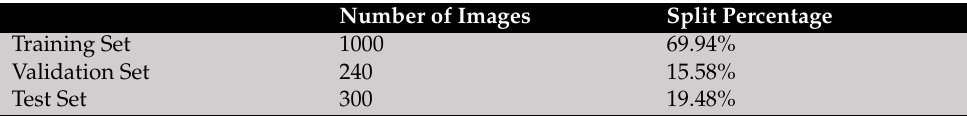
Table 4. Dataset